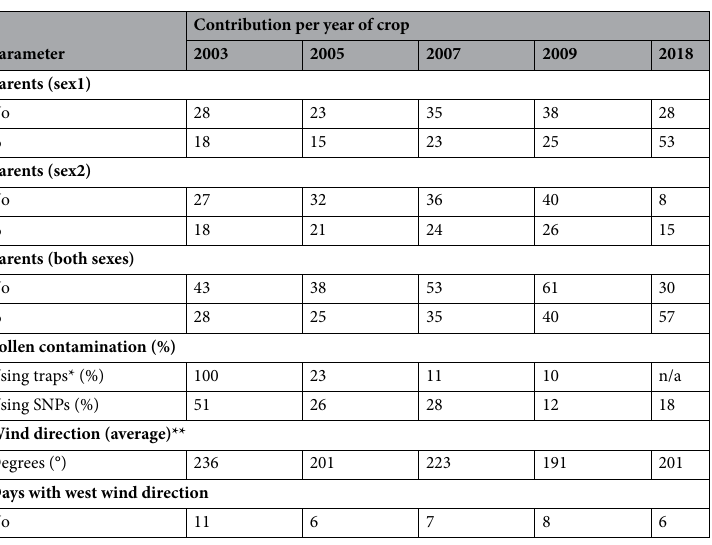
Table 2. Summary table for parental contributions (sex1, sex2, both sexes) for five seedlots collected at different years from the G1 white spruce orchard. Calculations were done using pedigree reconstruction using genomic profiles with a set of 2000 SNPs. Calculations were based on two different pedigree reconstructions: 420 seedlings and 151 parents for 2003, 2005, 2007 and 2009 (years before roguing), and 105 seedlings and 53 parents for 2018 (year after roguing). Pollen contamination (%) was calculated using two methods (traps and SNP profiling), wind direction in degrees and number of days with a west wind direction out of 15 days of assessment for each year. *Calculated following FGRMS (2016). **Calculated using the weather database from ‘Grande Prairie A’ station (https ://clima te.weath er.gc.ca/).